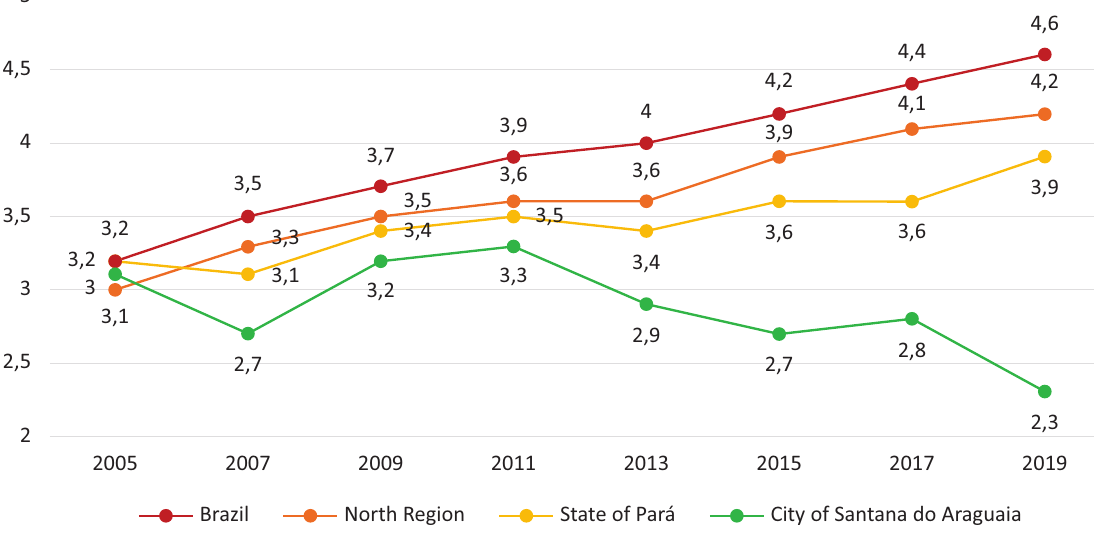
Figure 4. IDEB in the final years of elementary school in the public network. Source: INEP